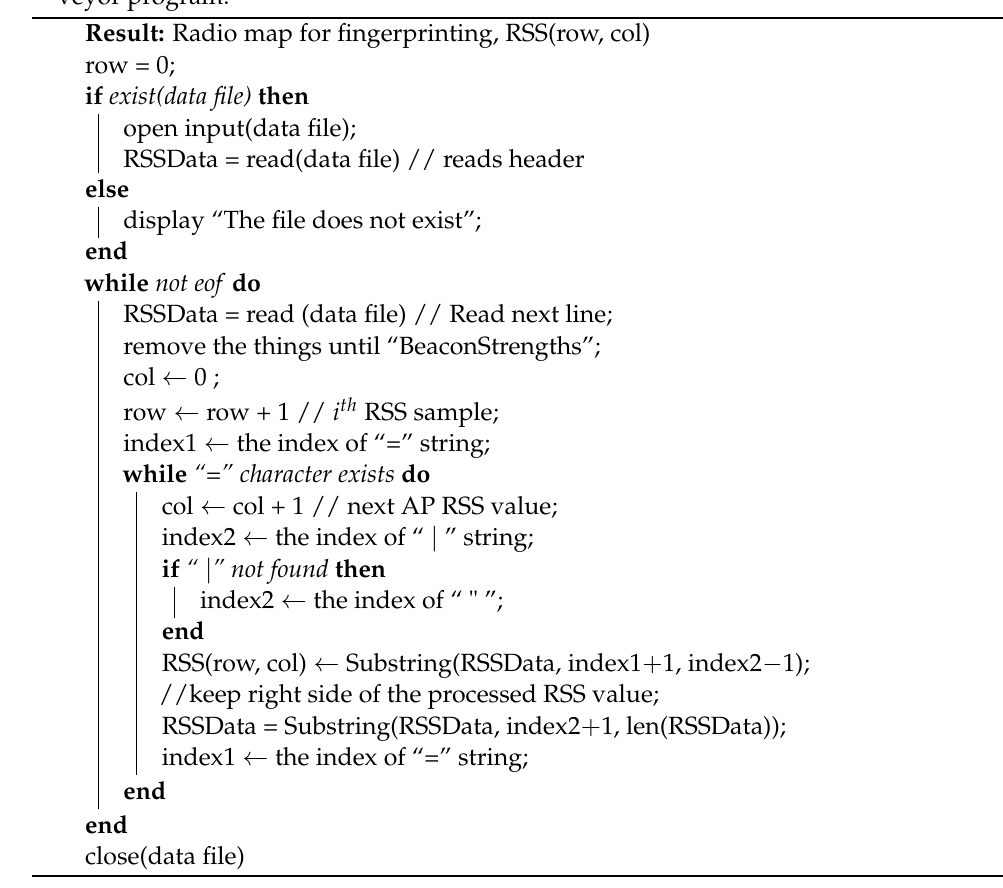
Algorithm 1: Data parsing method for the recorded XML data using Netsur- veyor